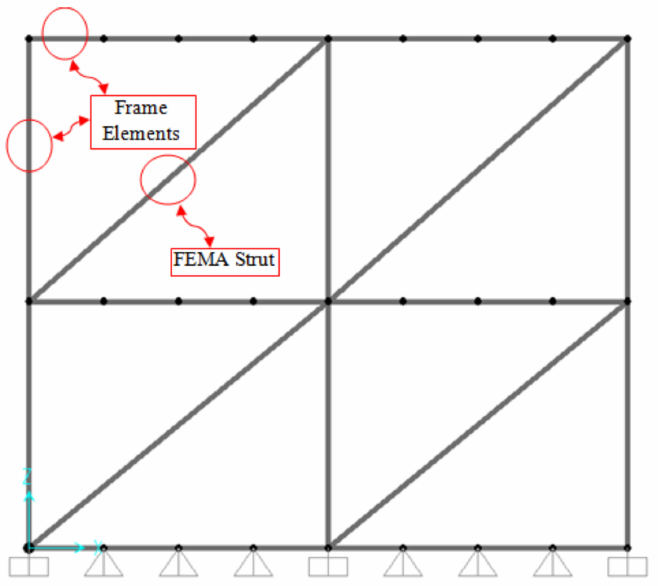
Figure 7. Schematic representation of FEMA strut Finite Element Model of H-building